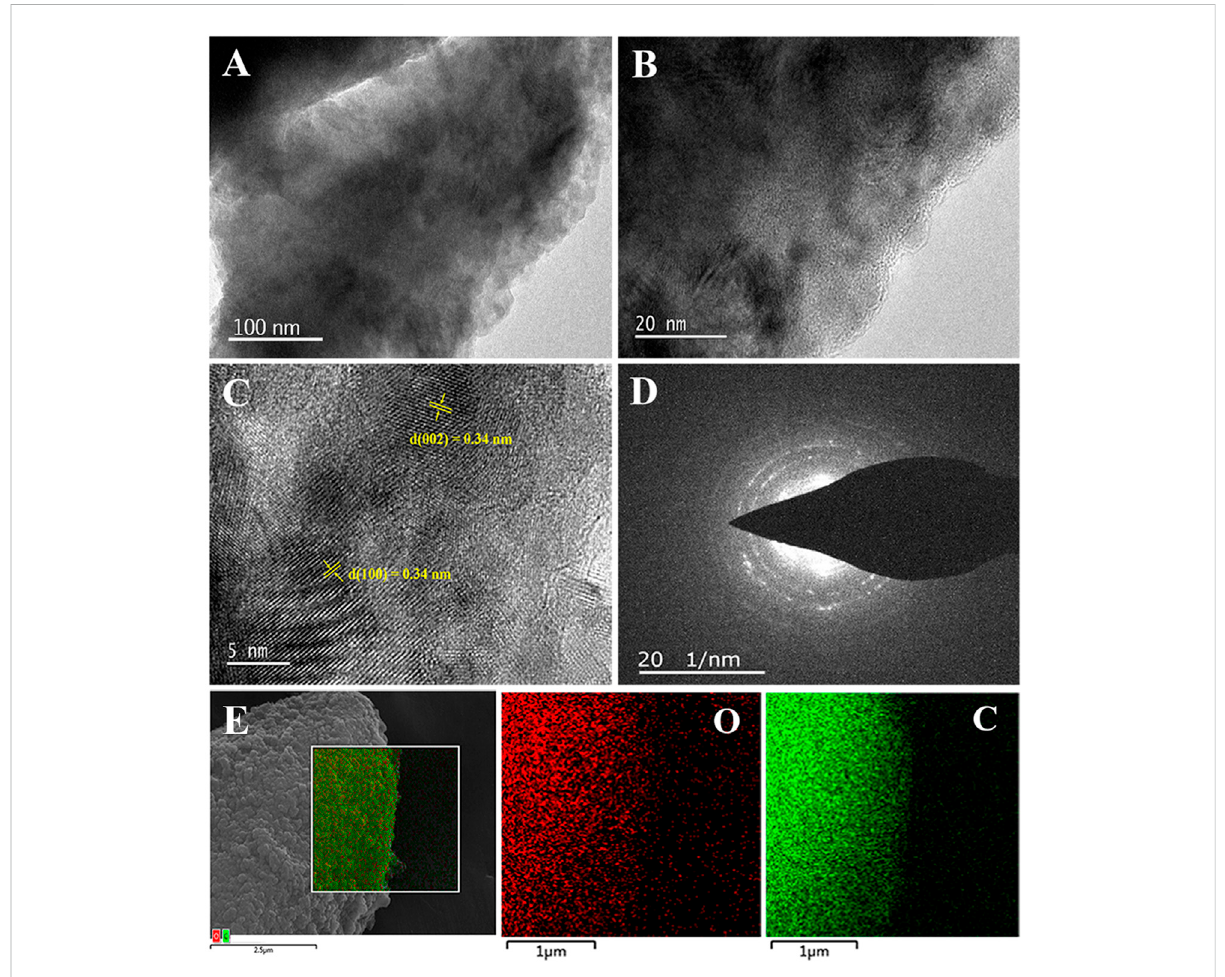
FIGURE 2 (A,B) TEM images of ECG-46 nanosheets at different magni fi cation; (C) HRTEM image; (D) SAED pattern; and (E) dark- fi eld SEM image and the elemental mapping of oxygen (O) and carbon (C) of the ECG-46